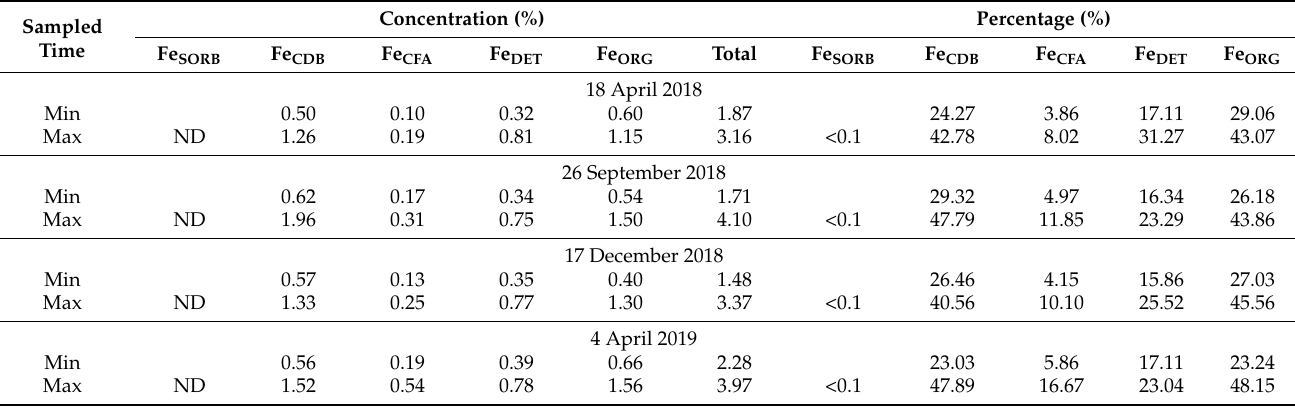
Table 3. The concentration and percentage ranges of sedimentary Fe in the five fractions of the sediments collected.from the DRE.